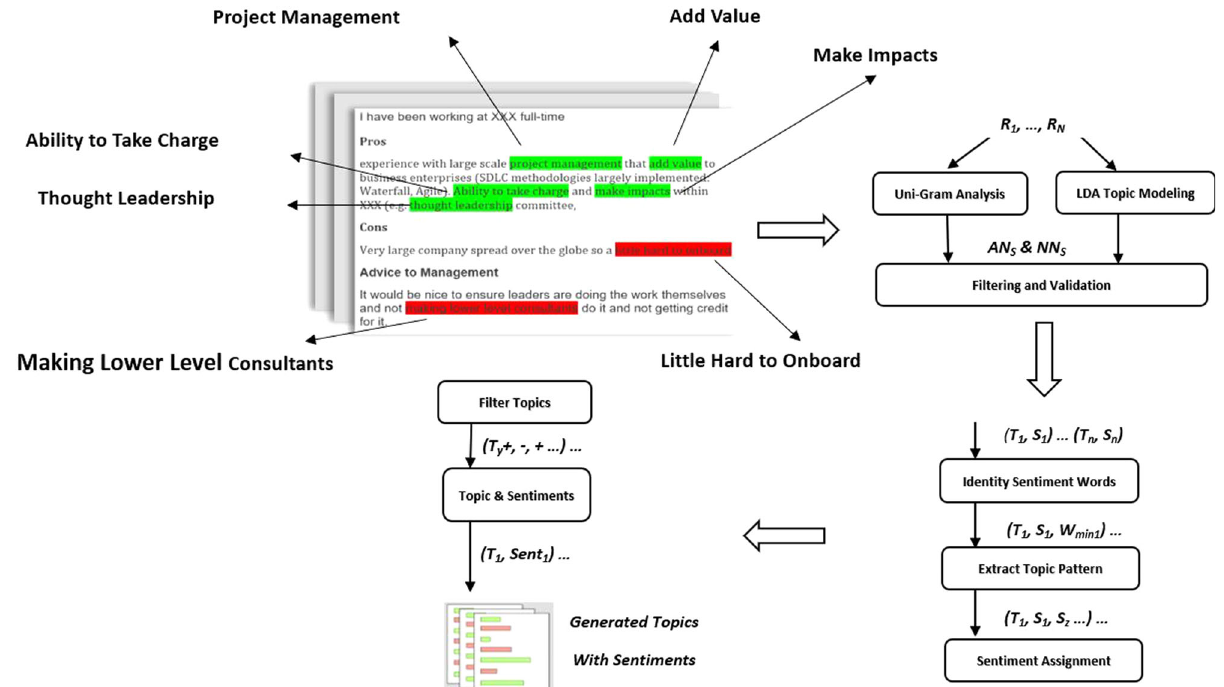
Fig. 4 The proposed multiscale algorithm. Visualized the algorithm as shown in Fig. 2 integrated with LDA topic modeling, seen in Fig. 3, in order to transform the text into informative and highly granular tables that may be presented via real-time BI tools and platforms.